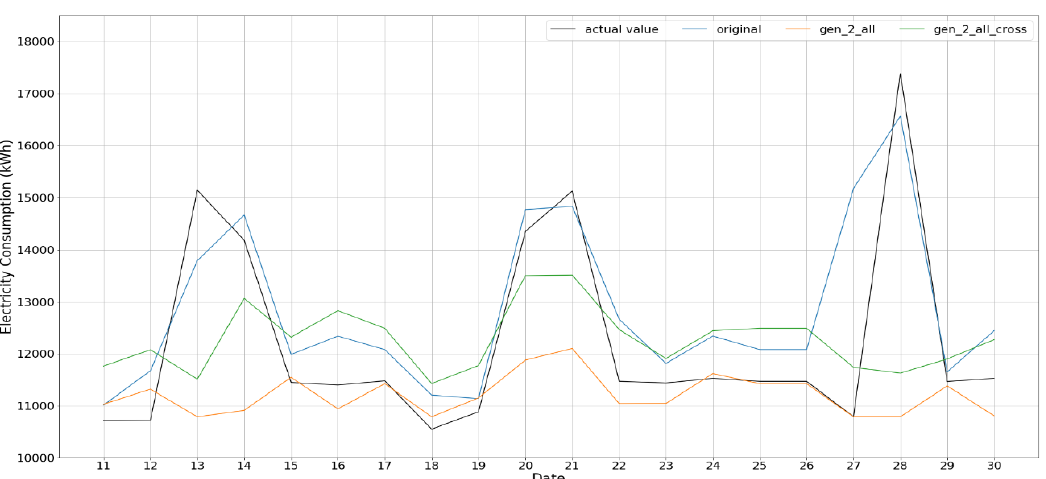
Figure 4. Gen_2_all and Gen_2_all_cross test result.